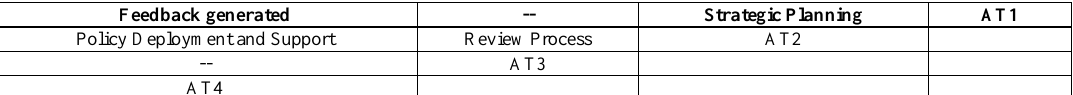
Table 5. Self-interaction interpretive matrix for actors in interpretive form.